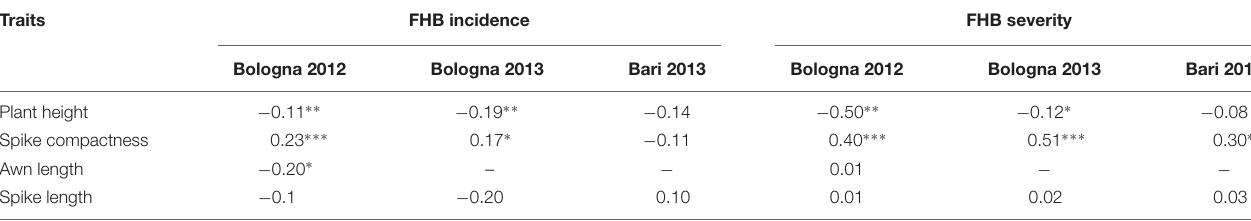
TABLE 3 | Coefficients of correlation between FHB incidence/severity and plant morphological traits in the RIL population derived from crossing FHB-resistant 02-5B-318 and FHB-susceptible cv. Saragolla, evaluated in in three environments (Bologna 2012, Bologna 2013, Bari 2013). Traits